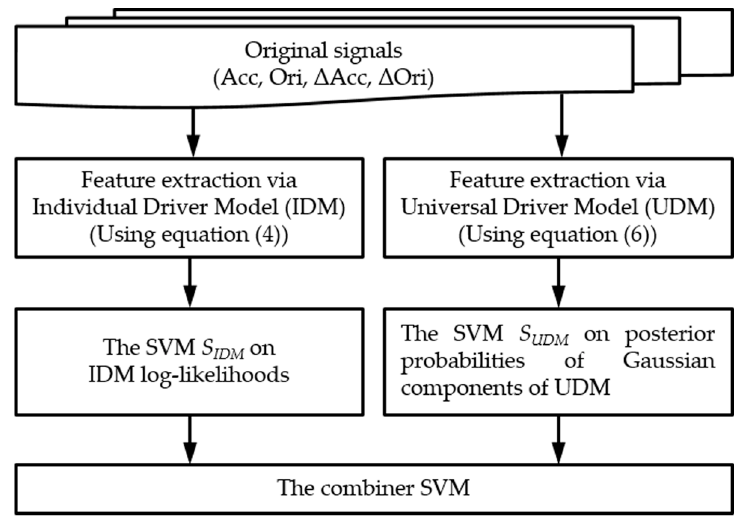
Figure 7. Proposed driving behavior model for a driver in a specific driving scenario.